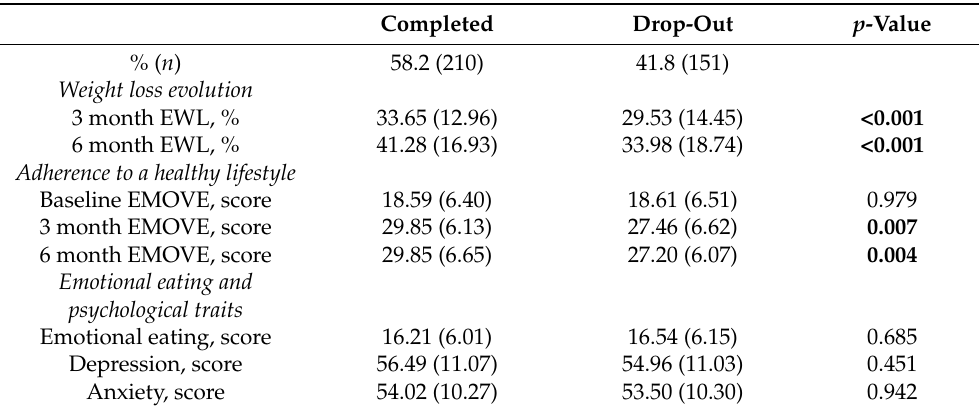
Table 4. Comparison of studied characteristics between participants who completed the study vs. participants who dropped